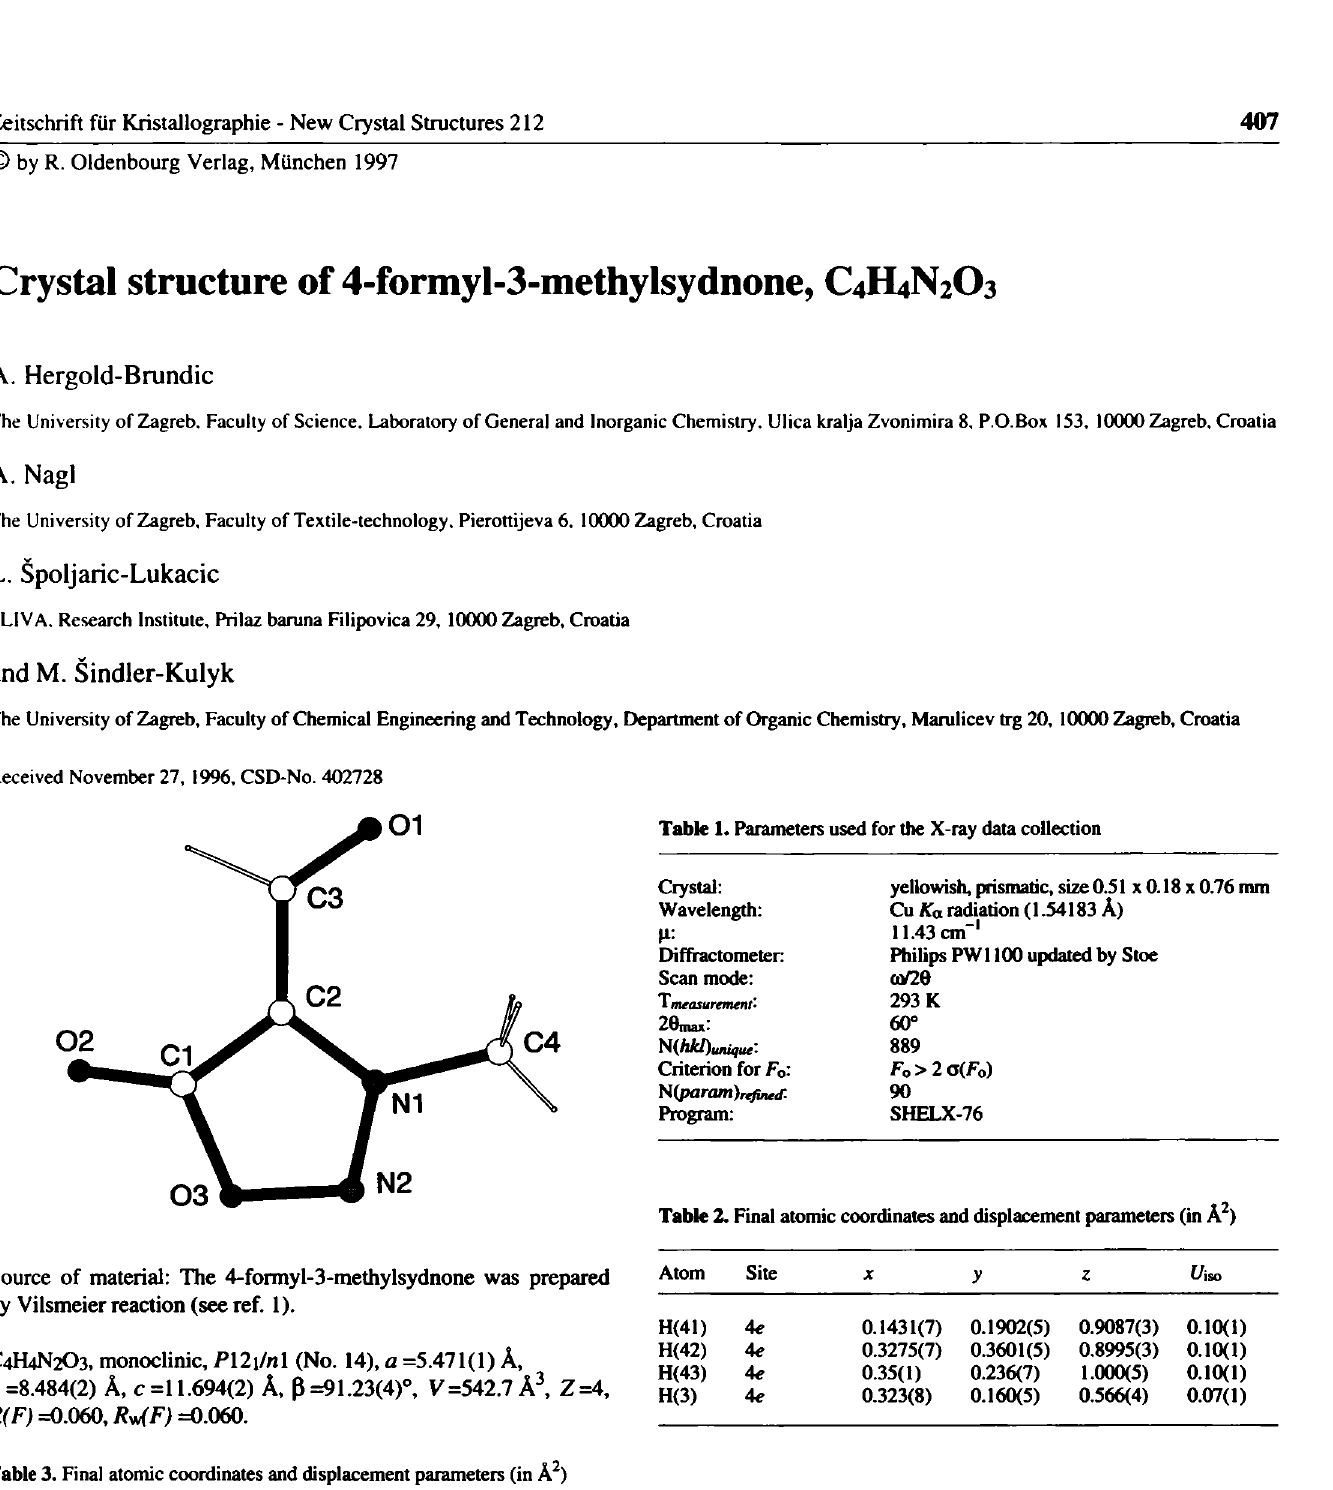
Table 3. Final atomic coordinates and displacement parameters (in À 2 )